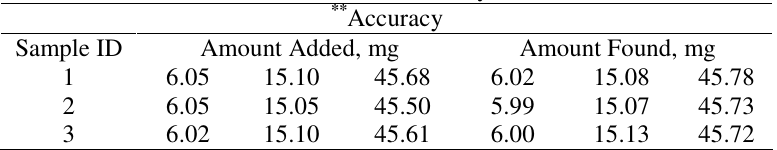
Table 2. Results of recovery studies.